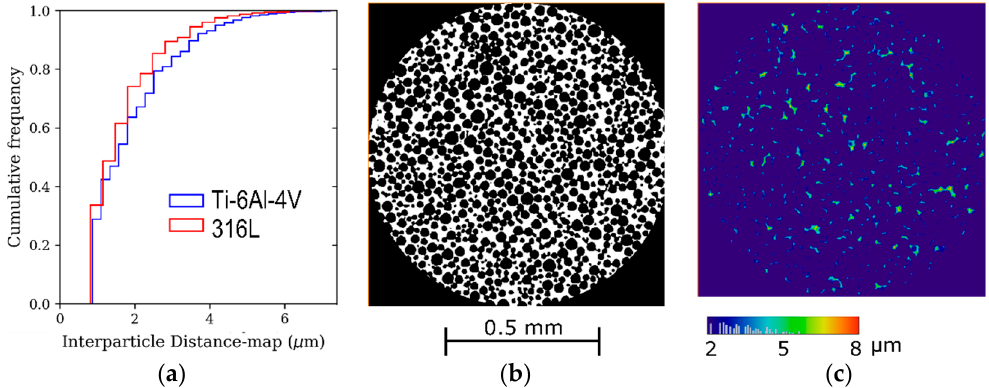
Figure 7. ( a ) Cumulative frequency of interparticle distance evaluated by 3D distance map for powder in capillary; ( b ) 2D slice of binarized and inversed volume; ( c ) the 3D distance transformation of ( b ).